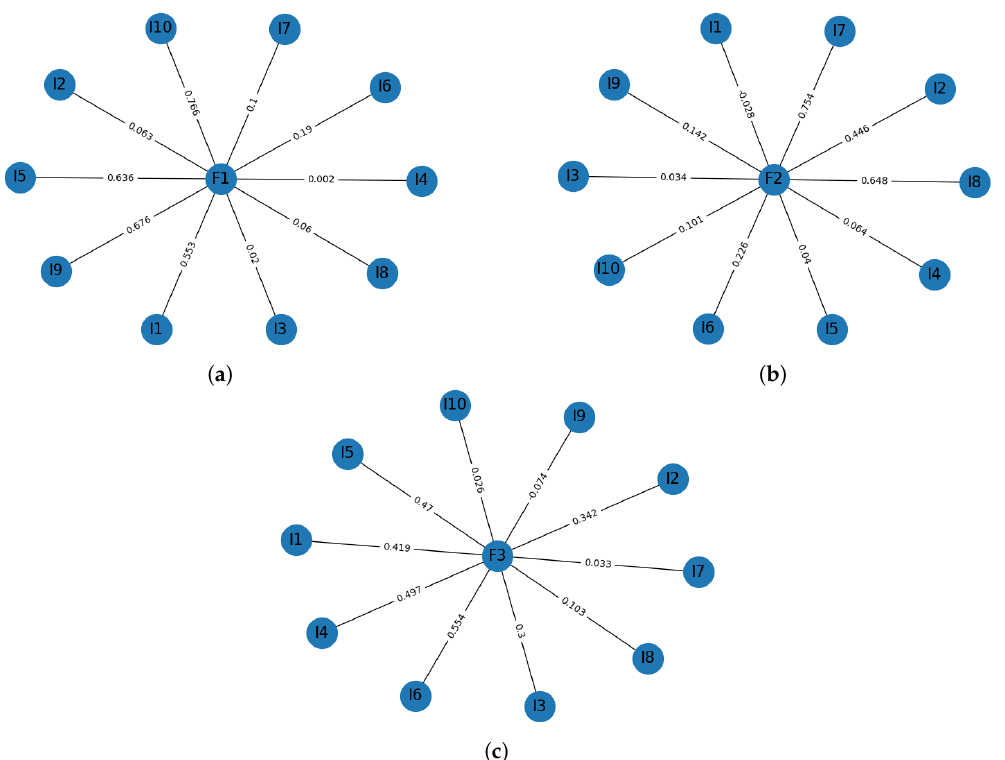
Figure 2. Factorial model for the BQREB instrument. ( a ) BQREB BP. ( b ) BQREB CM. ( c ) BQREB